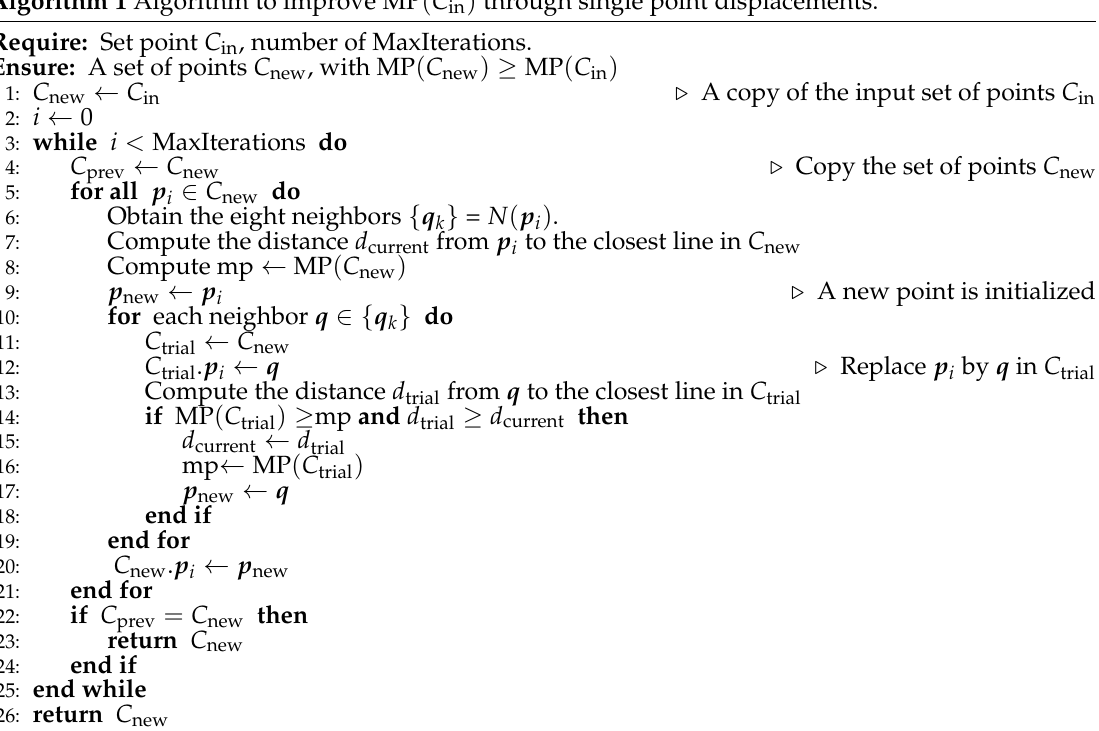
Algorithm 1 Algorithm to improve MP ( C in ) through single point